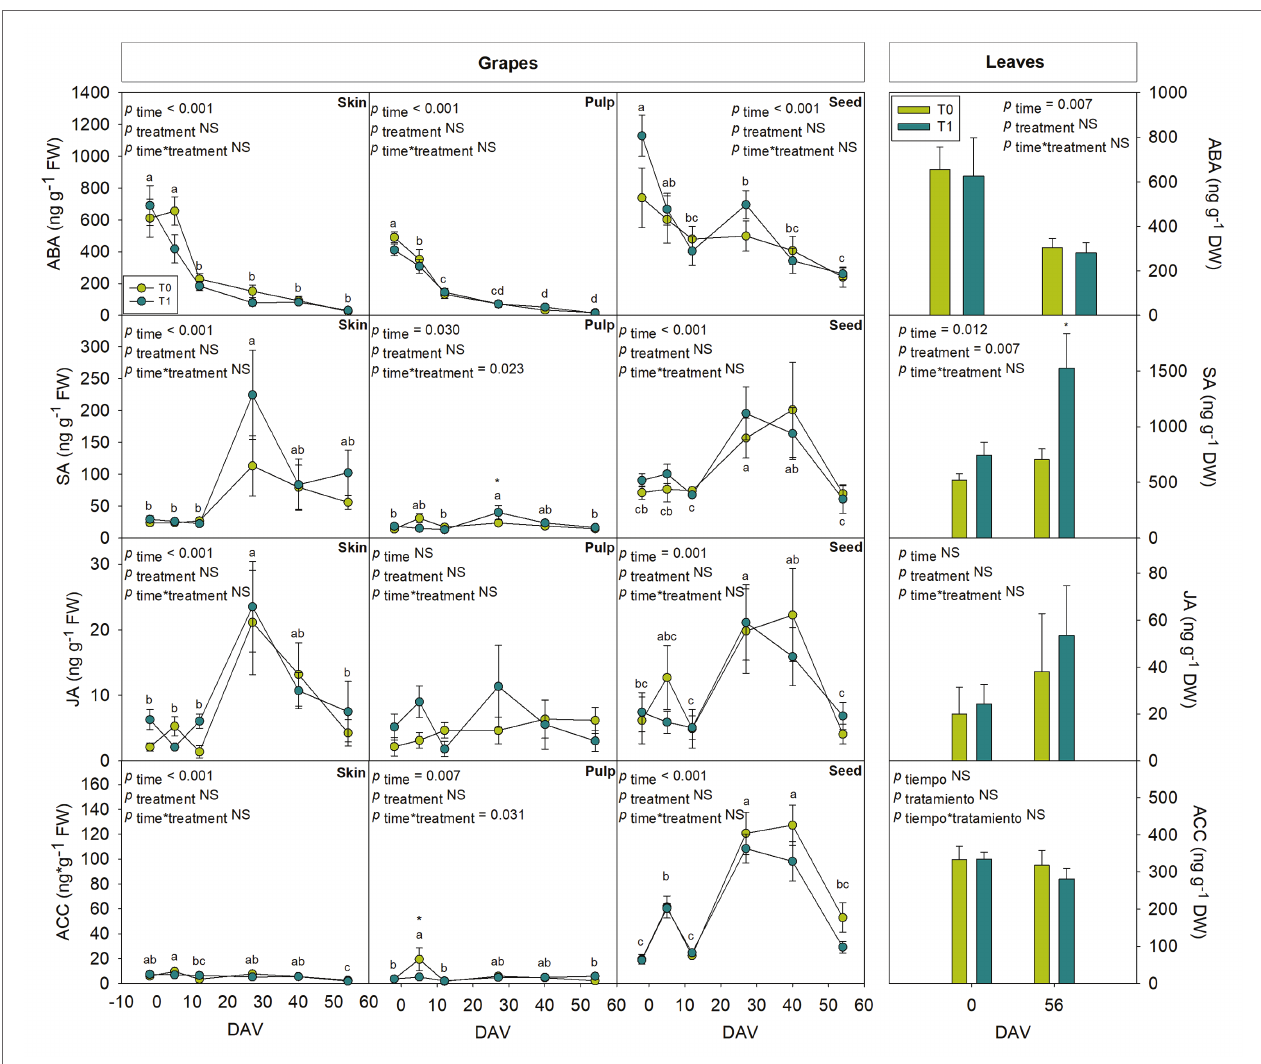
FIGURE 6 | Tissue-specific endogenous variations in ABA, JA, SA, and the ethylene precursor, 1-aminocyclopropane-1-carboxylic acid (ACC) in berries of “Merlot” grapes during ripening in non-irrigated (T0) and irrigated (T1) vineyards. ABA, SA, JA, and ACC contents in grape tissues, including the skin, pulp, and seeds throughout ripening are shown. Hormonal contents in leaves at the beginning and the end of the season are shown for comparison. Vertical bars indicate SE of six replicates. Different letters denote significant differences among sampling dates (Tukey’s HSD post-hoc test p < 0.05). The asterisks indicate significant differences between treatments ( p <